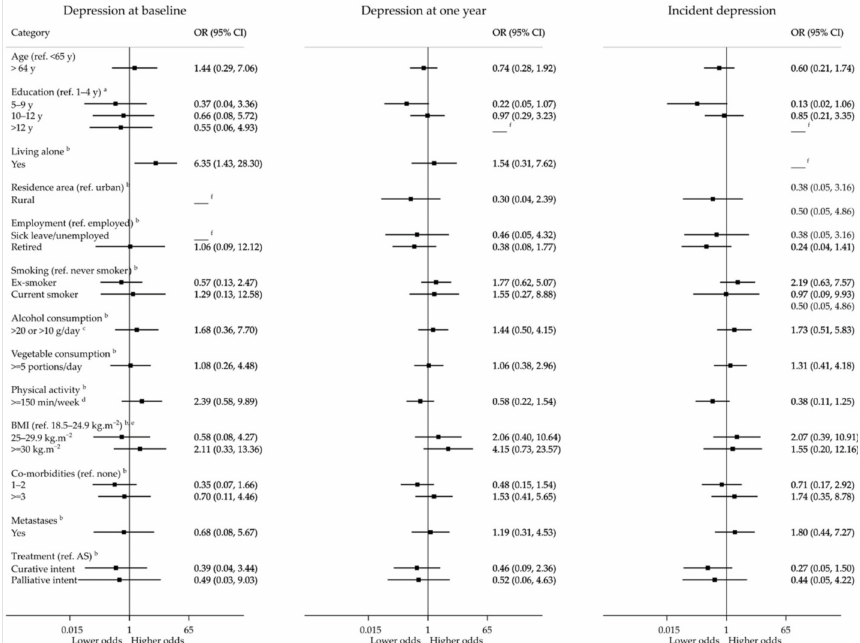
Figure 4. Associations between baseline variables and depression during the first year after prostate cancer diagnosis. AS, active surveillance; BMI, body mass index; a adjusted for age; b adjusted for age and education; c >20 g/day for men aged 18–64 years and >10 g/day for men aged 65 or older; d at least 150 min of physical activity weekly (sum of minutes of moderate physical activity + 2 × minutes of vigorous physical activity); e no participants had a BMI below 18.5 kg/m 2 ; f no participants had the